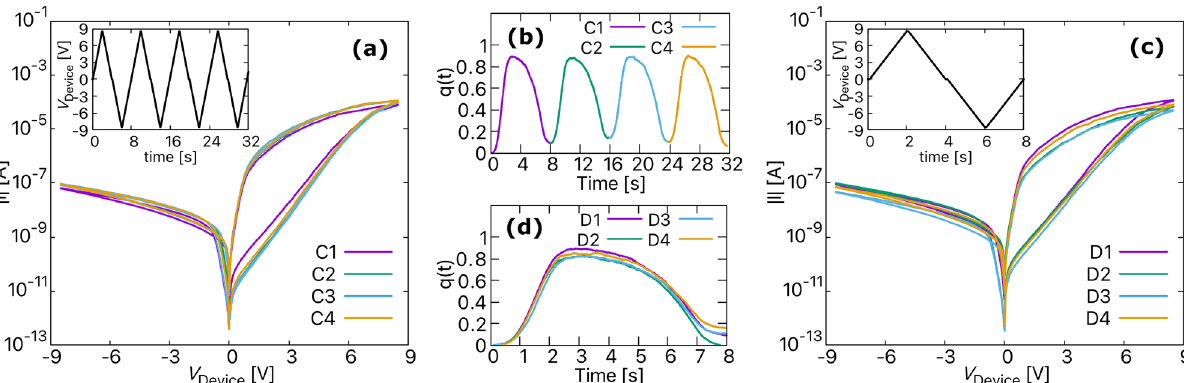
Figure 4. The simulated IV curves showing ( a ) cycle-to-cycle (C2C) variability obtained for four consecutive voltage sweeps with initial conditions given in the first row of Table 2. ( b ) The change in internal state of the device ( q ( t )) for C2C. ( c ) Device-to-device (D2D) variability obtained for a single voltage sweep but with different initial conditions given in Table 2. ( d ) The change in internal state of the device ( q ( t )) for D2D. The maximum applied voltage in both plots is ± 8.5